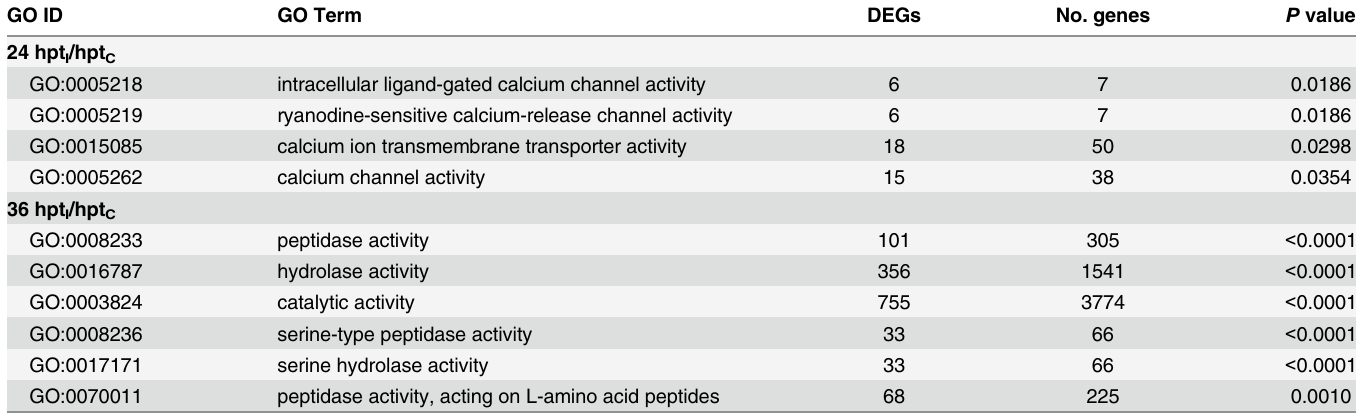
Table 2. GO terms for P . xylostella DEGs significantly enriched to 'Molecular Function'